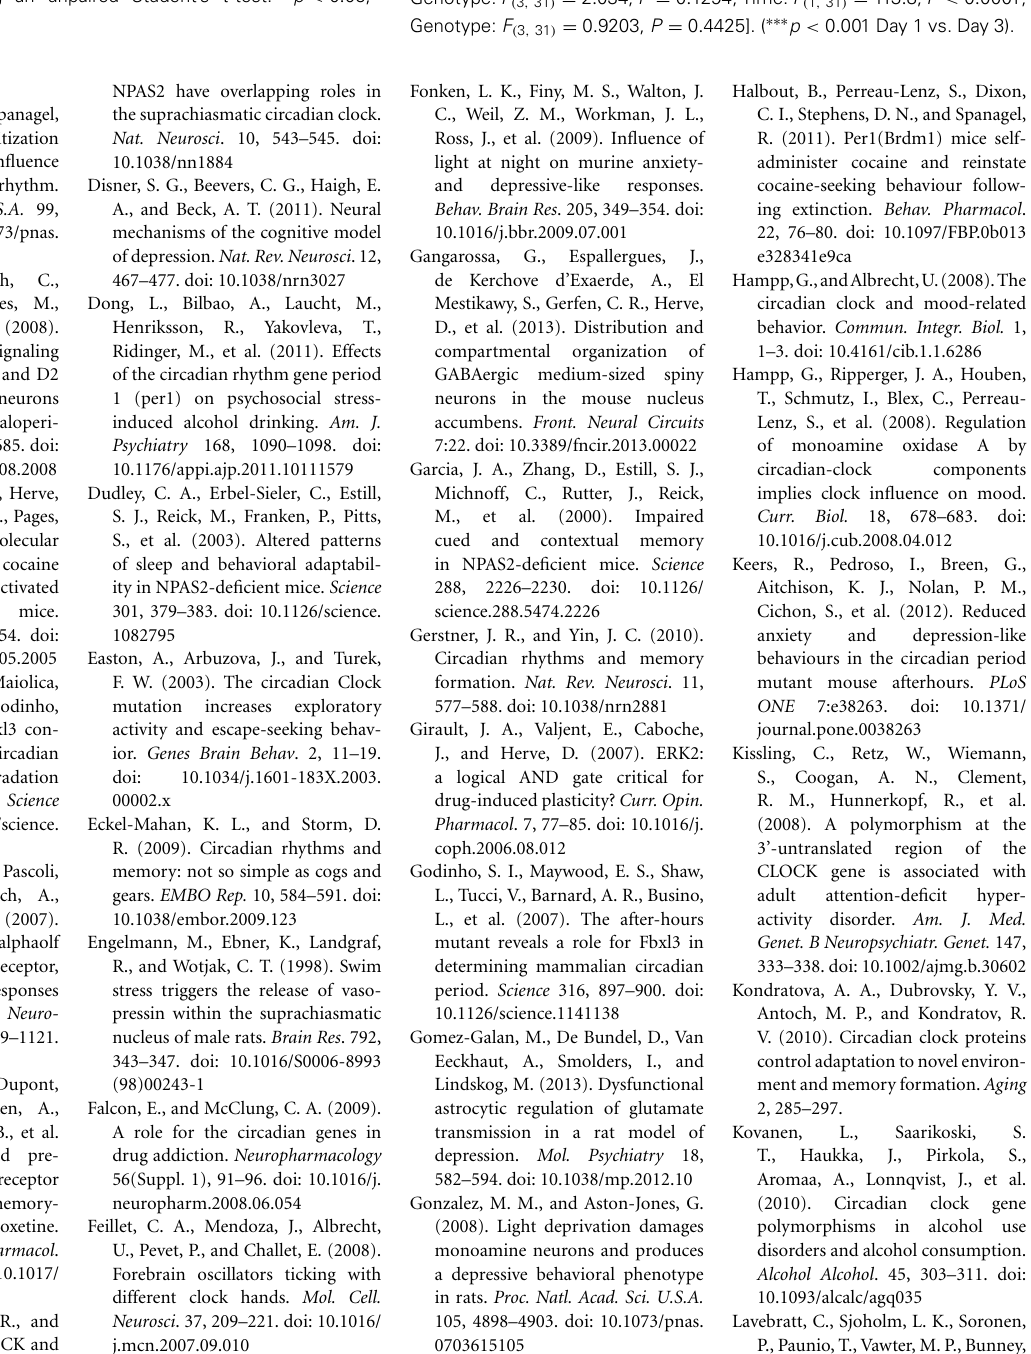
Figure S1 | Cocaine-induced acute hyperlocomotion. Locomotor activity induced by acute cocaine administration (7.5 and 15mg/kg) in wild type (WT) and Cry1 − / − Cry2 − / − mice ( n = 10–12 per experimental group). Measurements are shown as (A) raw data and (B) normalized data on the last day of habituation. Data (means ± sem) were analyzed using an unpaired Student’s t -test: ∗ p < 0 . 05, ∗∗ p < 0 . 01.